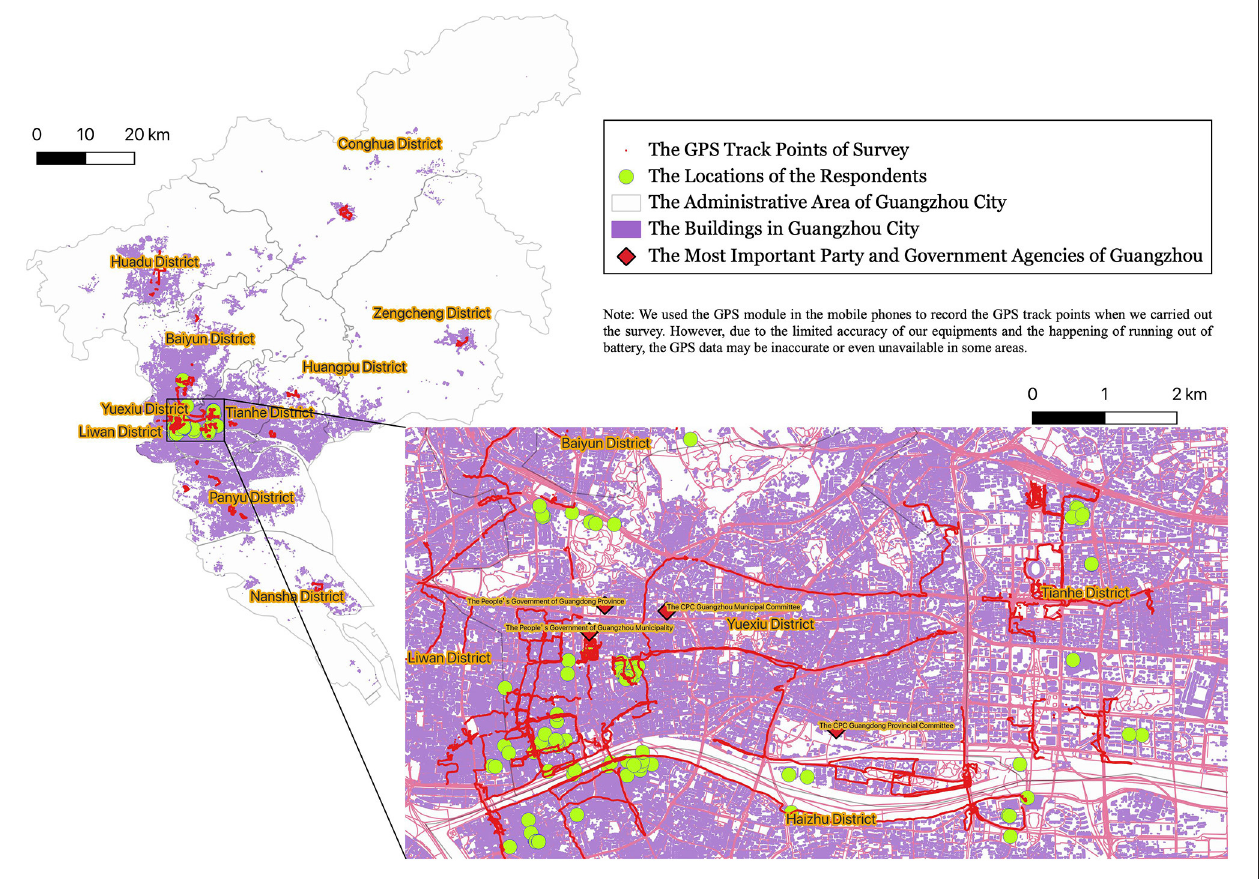
FIGURE 2 | The geographical characteristics of